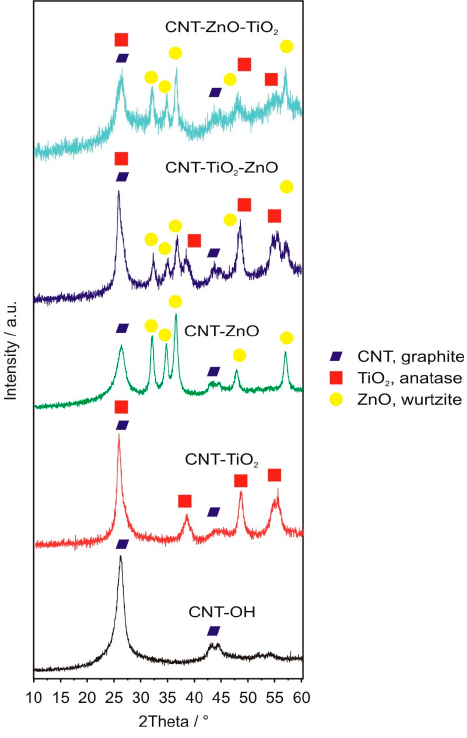
Figure 3. XRD diffractograms of the samples and the assignation of the